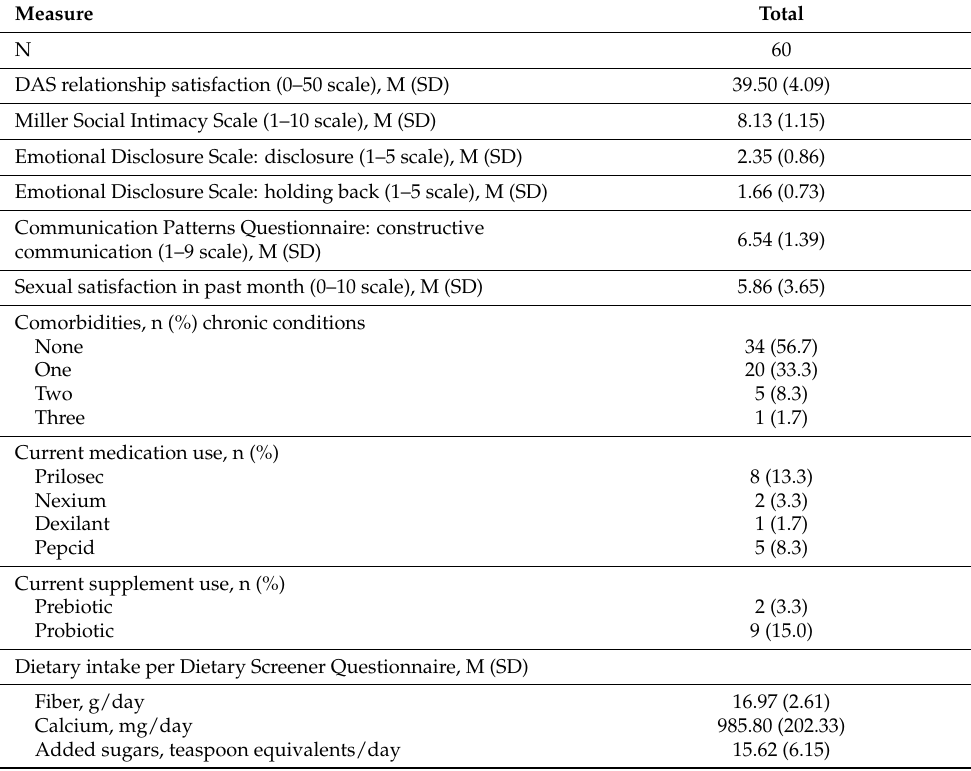
Table 2. Psychosocial and behavioral characteristics of the